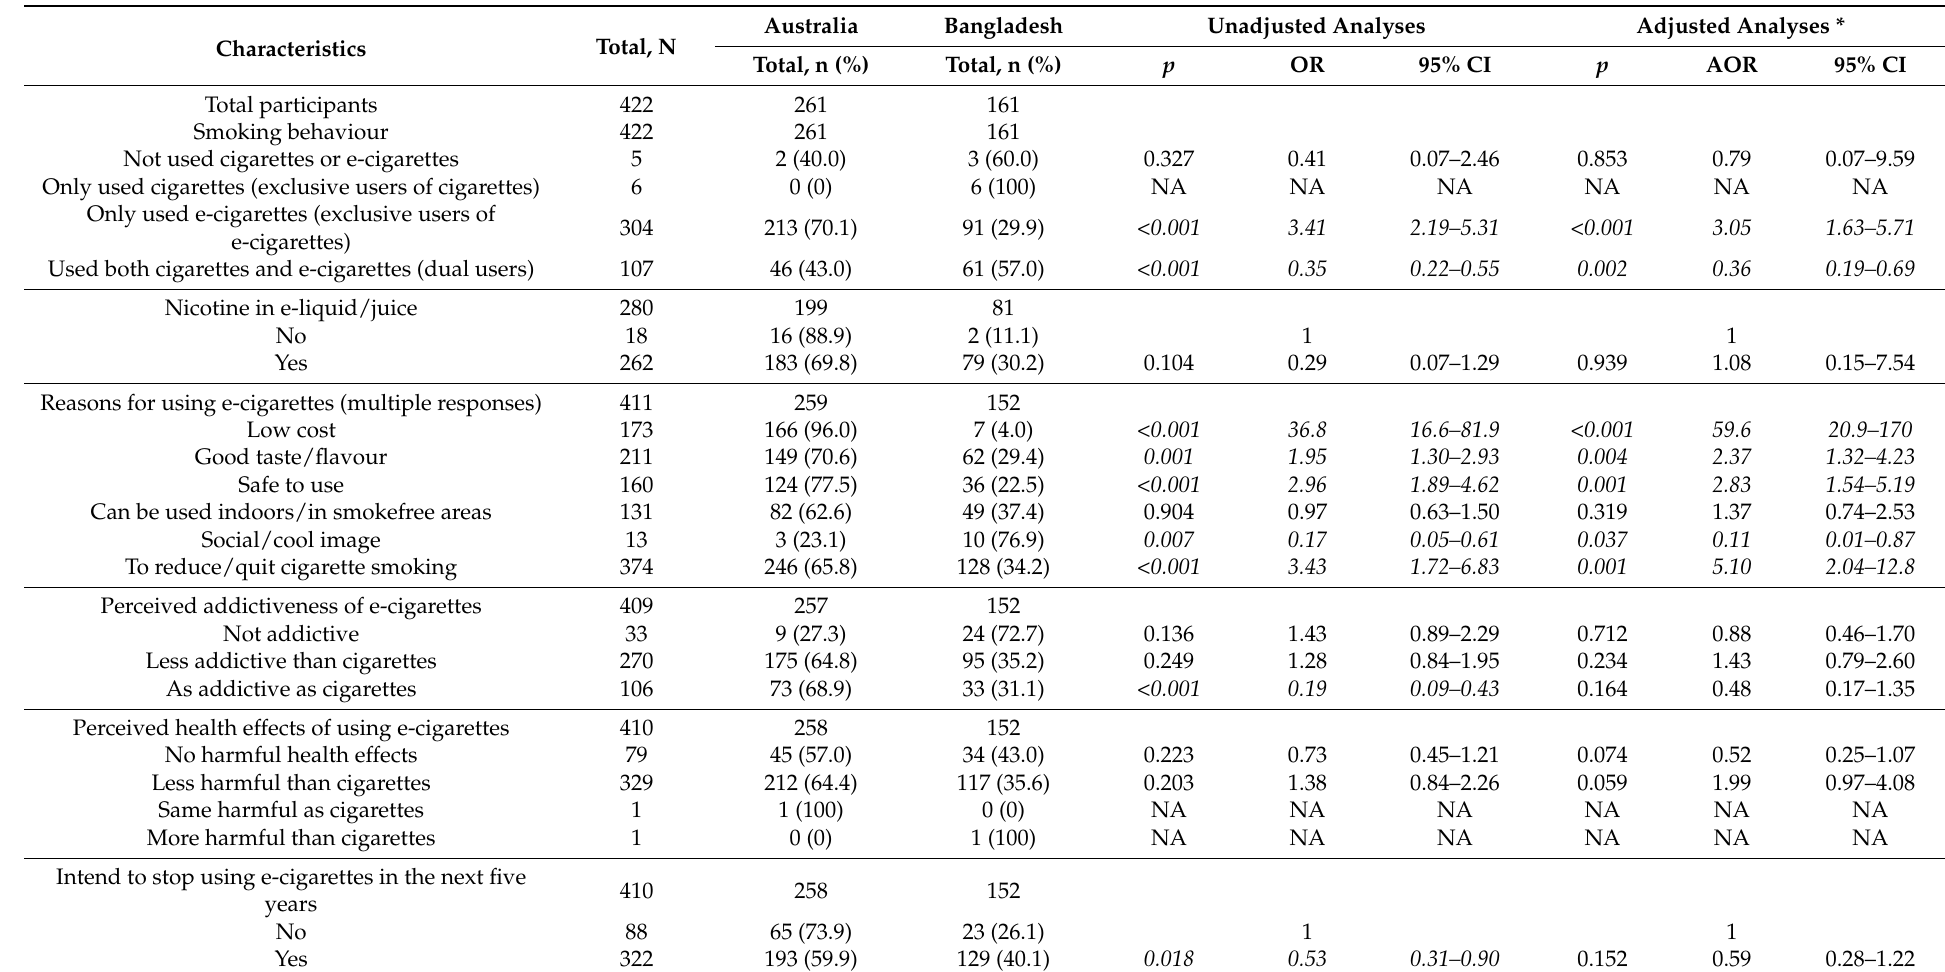
Table 4. Comparing the use of electronic cigarettes or vaping between the study participants in Australia and Bangladesh. Australia Bangladesh Unadjusted Analyses Adjusted Analyses Characteristics Total, N